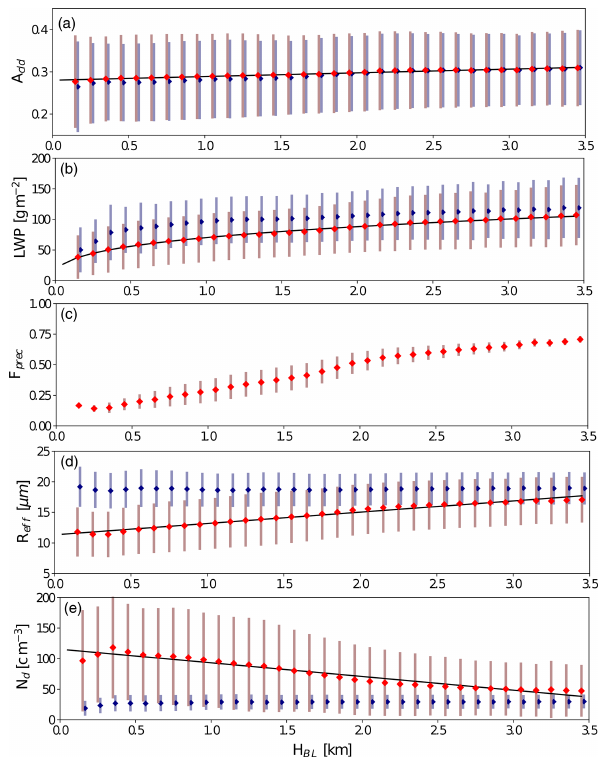
Figure 3. Scaling of (a) A cld , (b) LWP, (c) F prec , (d) R eff , and (e) N d against H BL . Mean and standard deviation of the 10-year subtropical stratocumulus climatology (see Fig. 2) are shown in red within each height bin (100m intervals). Fits across the climatology are superimposed in black (see Table 1 for details on fitting param- eters). The climatology of precipitating clouds is shown in blue. For completeness, the climatology for non-precipitating clouds is shown in Fig.